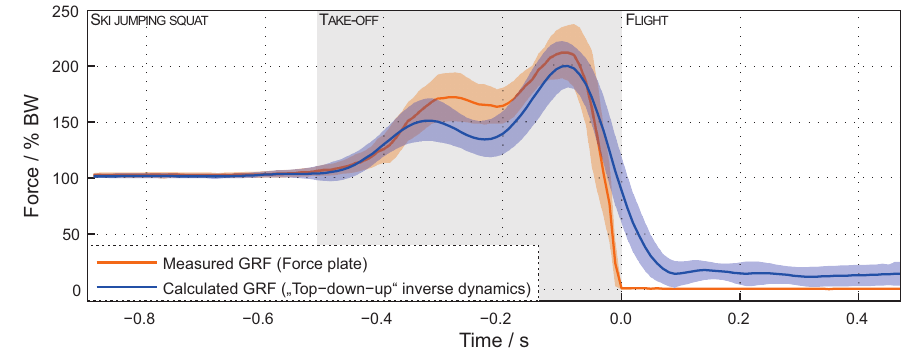
Figure 5. A comparison of the mean with the standard deviation of the calculated ground reaction force by the top-down-up method and the measured force with a force platform during the laboratory experiment.